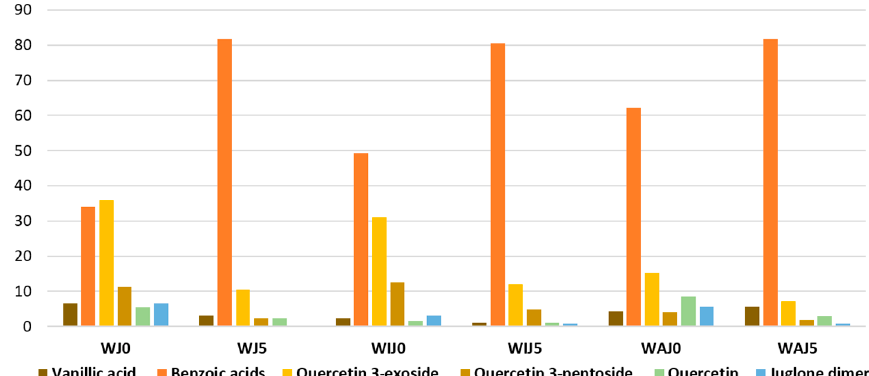
Figure 7. Histogram of percentage MS areas of vanillic acid, benzoic acids (3,4-dihydroxybenzoic acid + 4-hydroxybenzoic acid + 3-hydroxybenzoic acid), quercetin 3-hexoside (quercetin 3-galactoside + quercetin 3-rhamnoside) and quercetin 3-pentoside (quercetin 3-arabinoside + quercetin 3- xyloside), quercetin and juglone dimer (tentative attribution) in yarns died with Juglans regia nuts; samples are labelled according to the following code: W = wool, J = dyed with Juglans regia , I = iron-mordant, A = aluminum mordant, 0 = nonaged, 5 = aged for 500 h. A full list of the samples labels is provided in Table